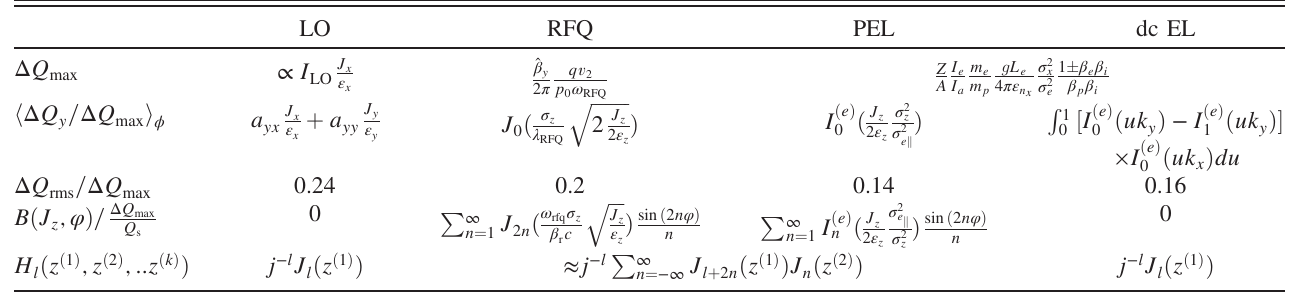
TABLE I. Tune spreads, betatron phase factors B ð J σ 2 J x;y x;y . and LO, k 2 ε x;y ¼ σ 2 x;y e ⊥ LO